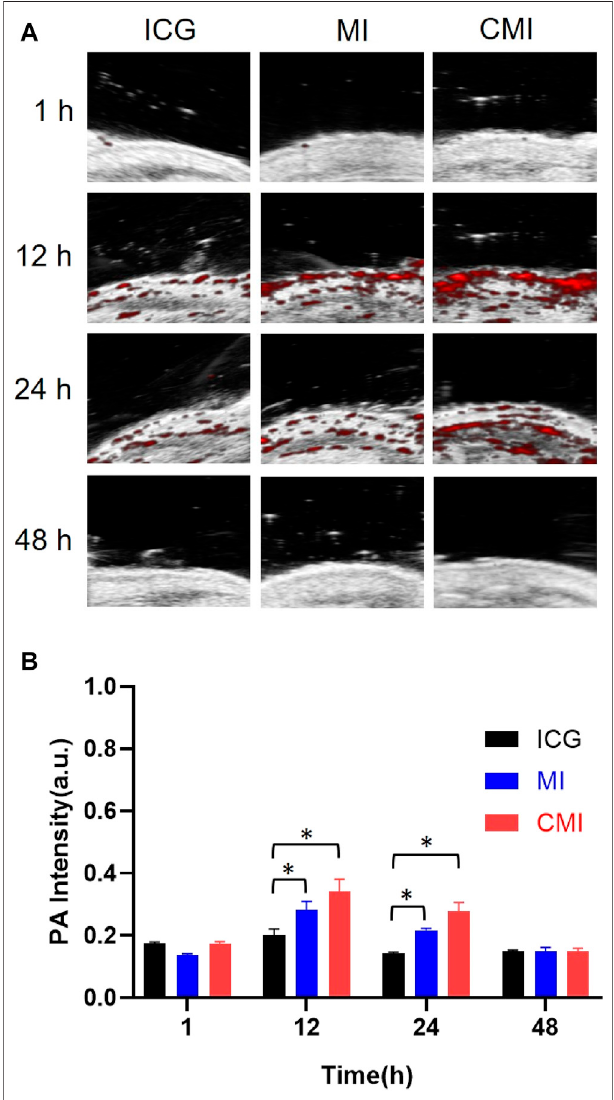
FIGURE7| In vivo PAimaging ofHelatumor – bearing nude mice. (A) PA images of the tumor region. (B) Fluorescent signal measurement of ICG formulationsinthetumor region.Thetumors werecutcompletely,followedby treatment with ICG, MI, and CMI (containing an ICG dose of 10 mg/kg) via the tail vein ( n (cid:2) 3/group). At 1, 12, 24, and 48 h after injection, the fl uorescent signals were measured by using the Step and Shoot mode with 100 angles and 15 pulses per angle in the V evo LAZR-X multimode imaging system. The results were processed by V evo LAB 3.2.0 software (* < 0.05).